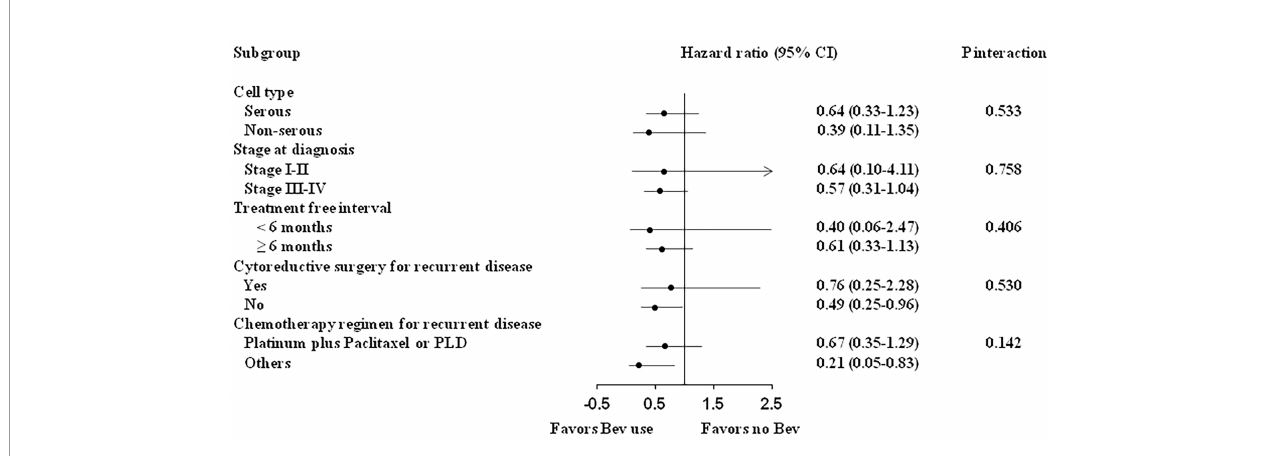
FIGURE 3 | Subgroup analysis of the ef fi cacy of bevacizumab on progression-free